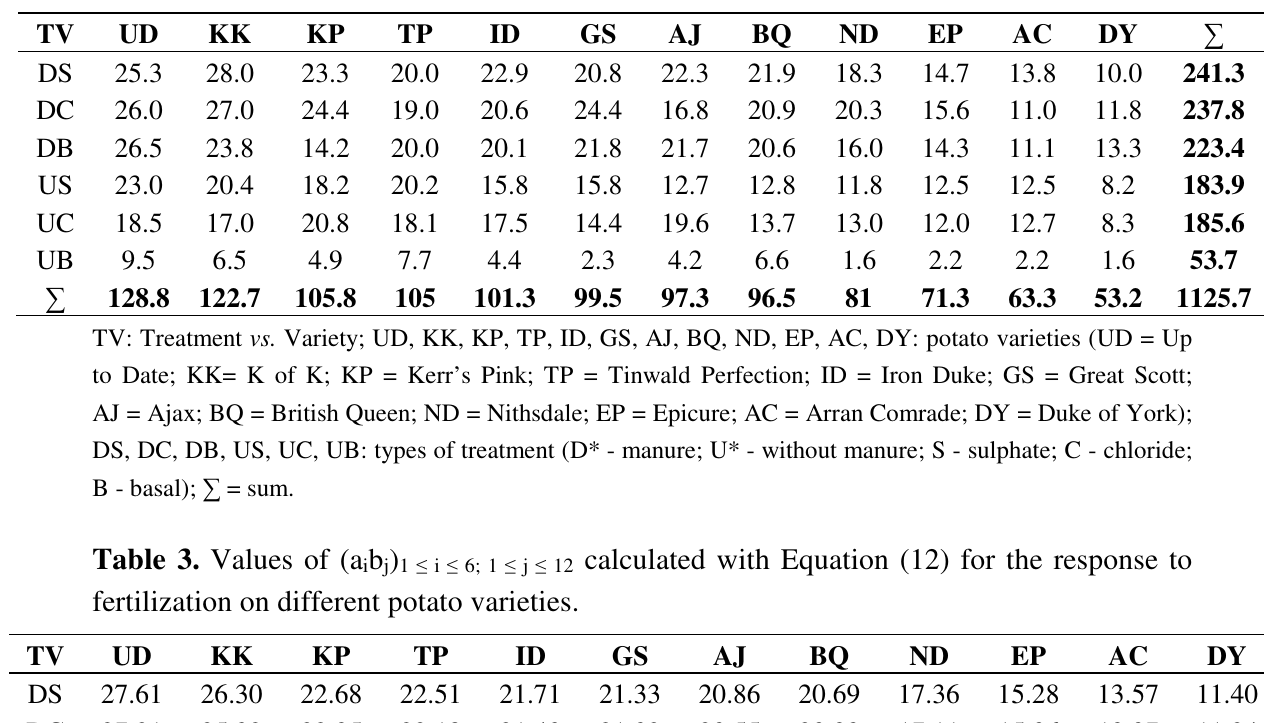
Table 2. Experimental values: response to fertilization with manure on different potato varieties.